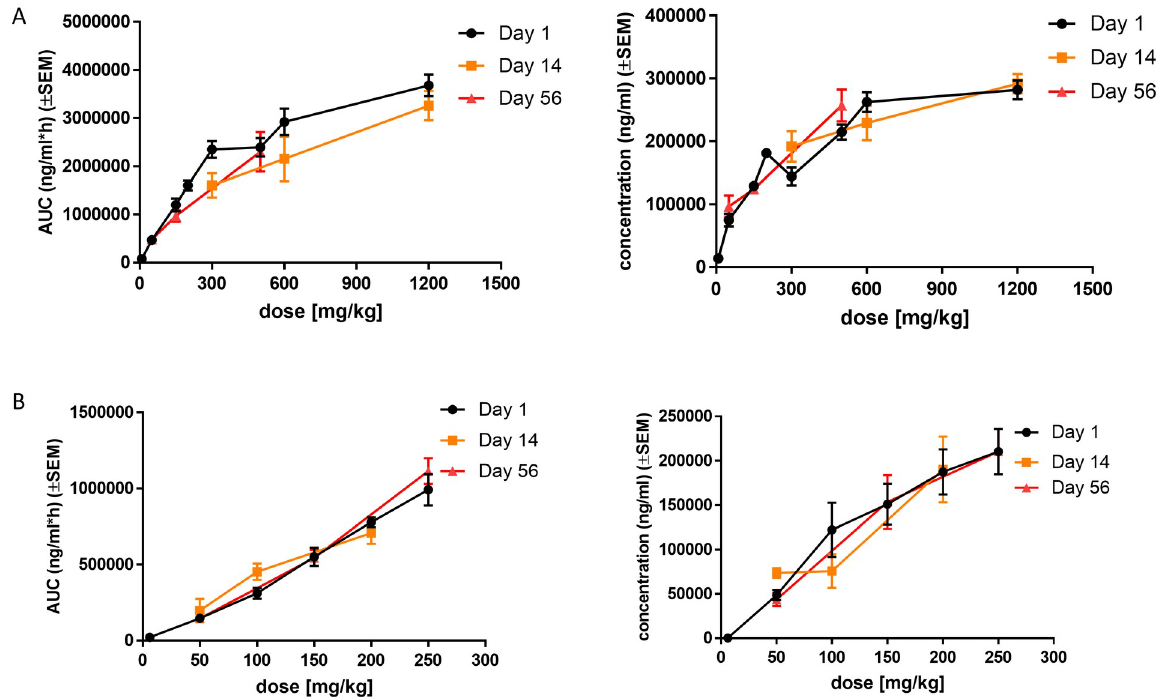
Fig 7. Pharmacokinetic profiles of CPL207280 in repeated-dose administration 14- and 56-day study in rats and monkeys. Wistar Han rats were orally given 300, 600 and 1200 mg/kg/day of the test compound for 14 days and 50, 150, 500 mg/kg/day (n = 6, 3 males + 3 females) for 56 days (A). Cynomolgus monkeys were orally given 50, 100, 200 mg/kg (n = 4, 2 males + 2 females) of the test compound and 50, 150, 250 mg/kg/ day (n = 8, 4 males + 4 females) for 56 days (B). Plots represent dose–exposure and dose–C max relationships. Data are mean ± SEM.